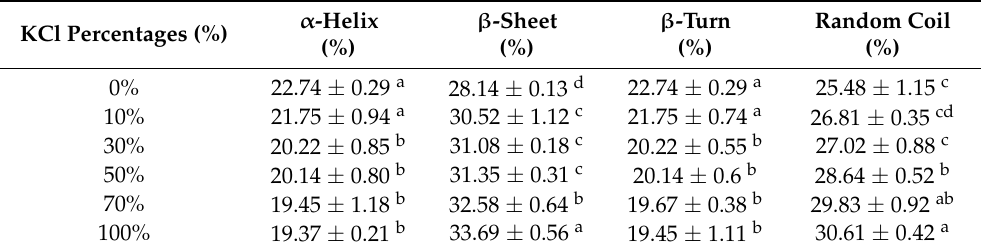
Table 1. Change in MP secondary structure relative content of salted tilapia fillets as affected by partial replacement of NaCl with